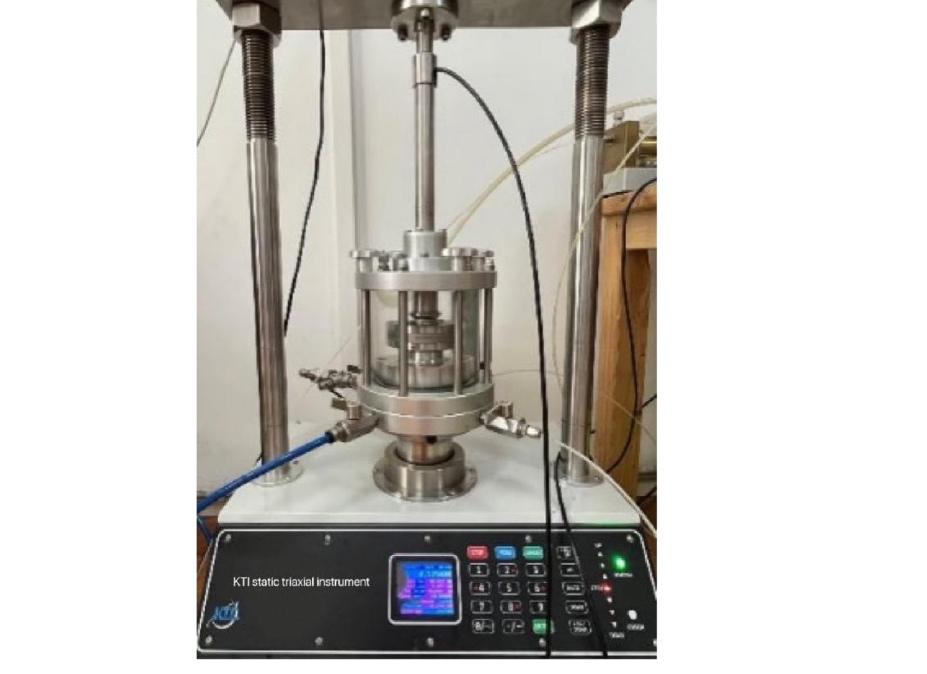
Figure 19. Triaxial Penetration System.